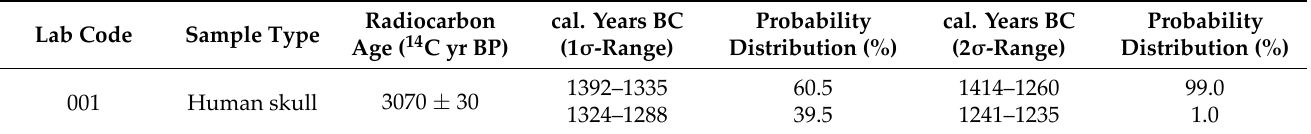
Table 1. Radiocarbon dating of a human skull fragment recovered from the Zhengzhou Shang City HSD.